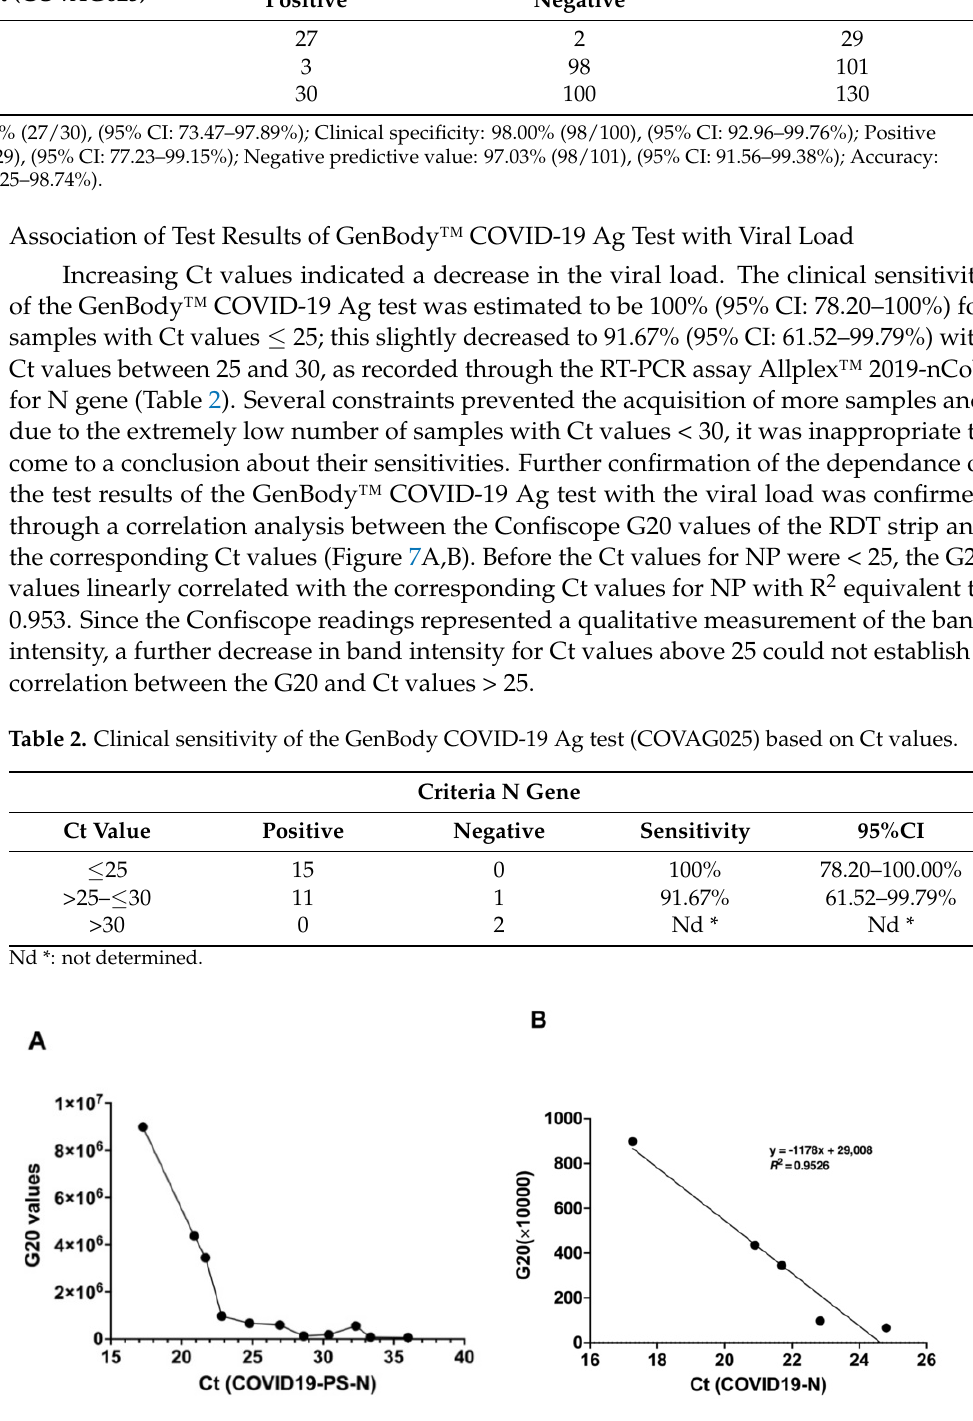
Table 1. Results of the test using the GenBody COVID-19 Ag test (COVAG025). Evaluation Results of Test Equipment